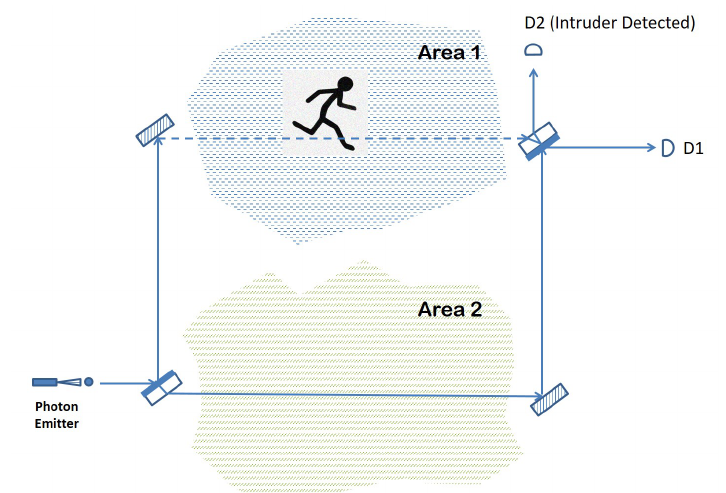
Figure 2. Quantum sensor based on single-photon